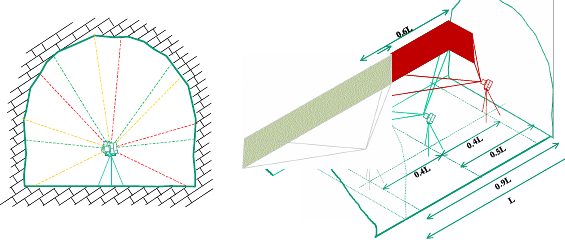
Figure 10. Block geometry of the mining system.